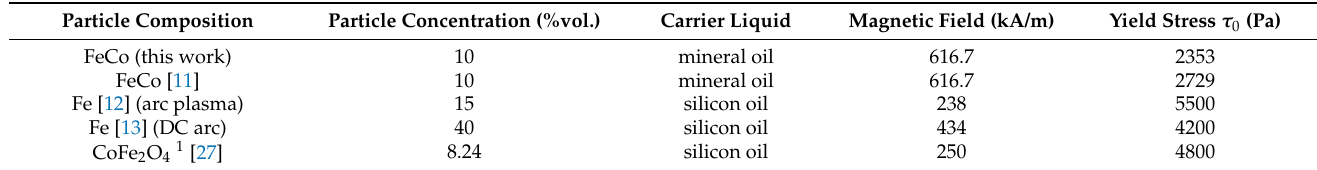
Table 7. Comparison of different MR fluids prepared with nanoparticles of Fe and FeCo as magnetic fillers. Adapted from Table 2 in [11]. Particle Composition Particle Concentration